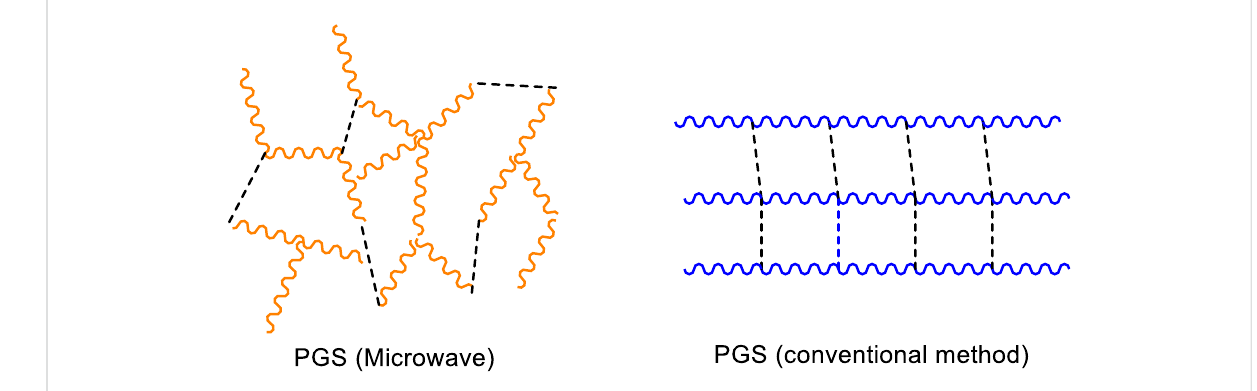
FIGURE 4 Proposed images of the possible structures of PGS prepolymerized via microwave and conventional methods. Dashed line: cross-linking. Images inspired by Lau et al. (2017).